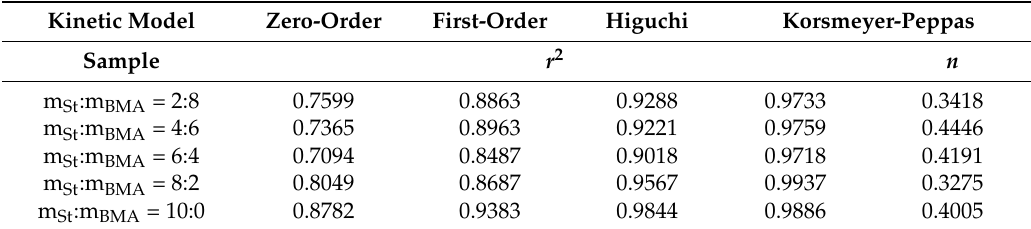
Table 2. Fitting results for release curves at various monomer ratios.